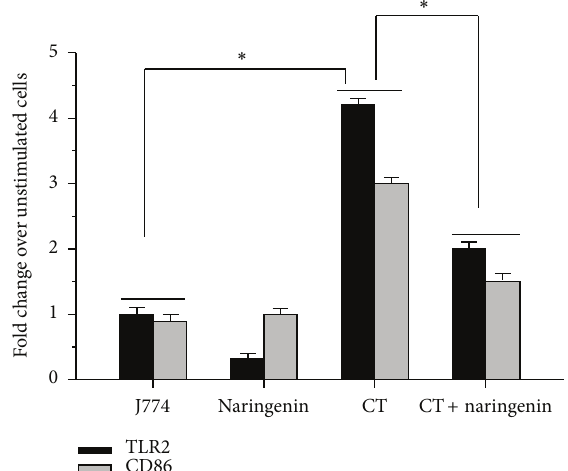
Figure 4: Naringenin reduces the transcriptional activation of TLR2 and CD86 by C. trachomatis in mouse J774 macrophages. Macrophages (3 × 10 6 cells/mL) were left uninfected or infected with live C. trachomatis (3 × 10 5 IFU/well). After 2-day infection of macrophages with C. trachomatis (CT), naringenin (1 𝜇 g/mL) was added to macrophage cultures and 2 days later total RNA was extracted as described in Section 2. One step qRT-PCR was used to quantify the mRNA gene transcripts of TLR2 and CD86. ∗ 𝑃 < 0.05 is considered significant when compared to untreated cells (J774) and to cells treated with CT or CT + naringenin. Data shown is an